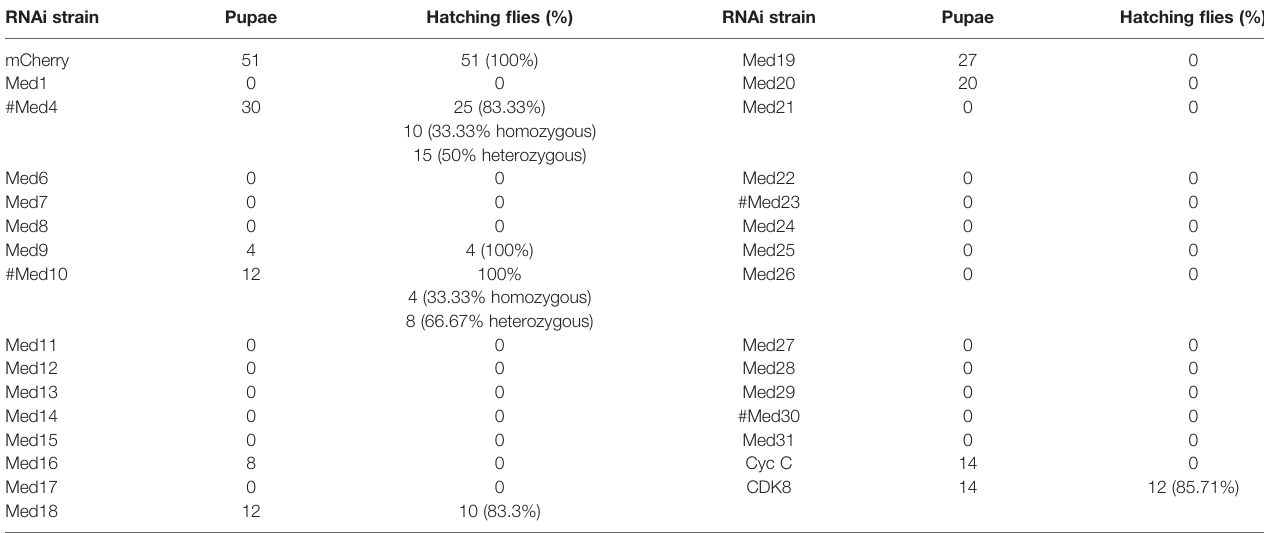
TABLE 1 | Validation of Med RNAi fl ies lethality at 29°C. RNAi strain